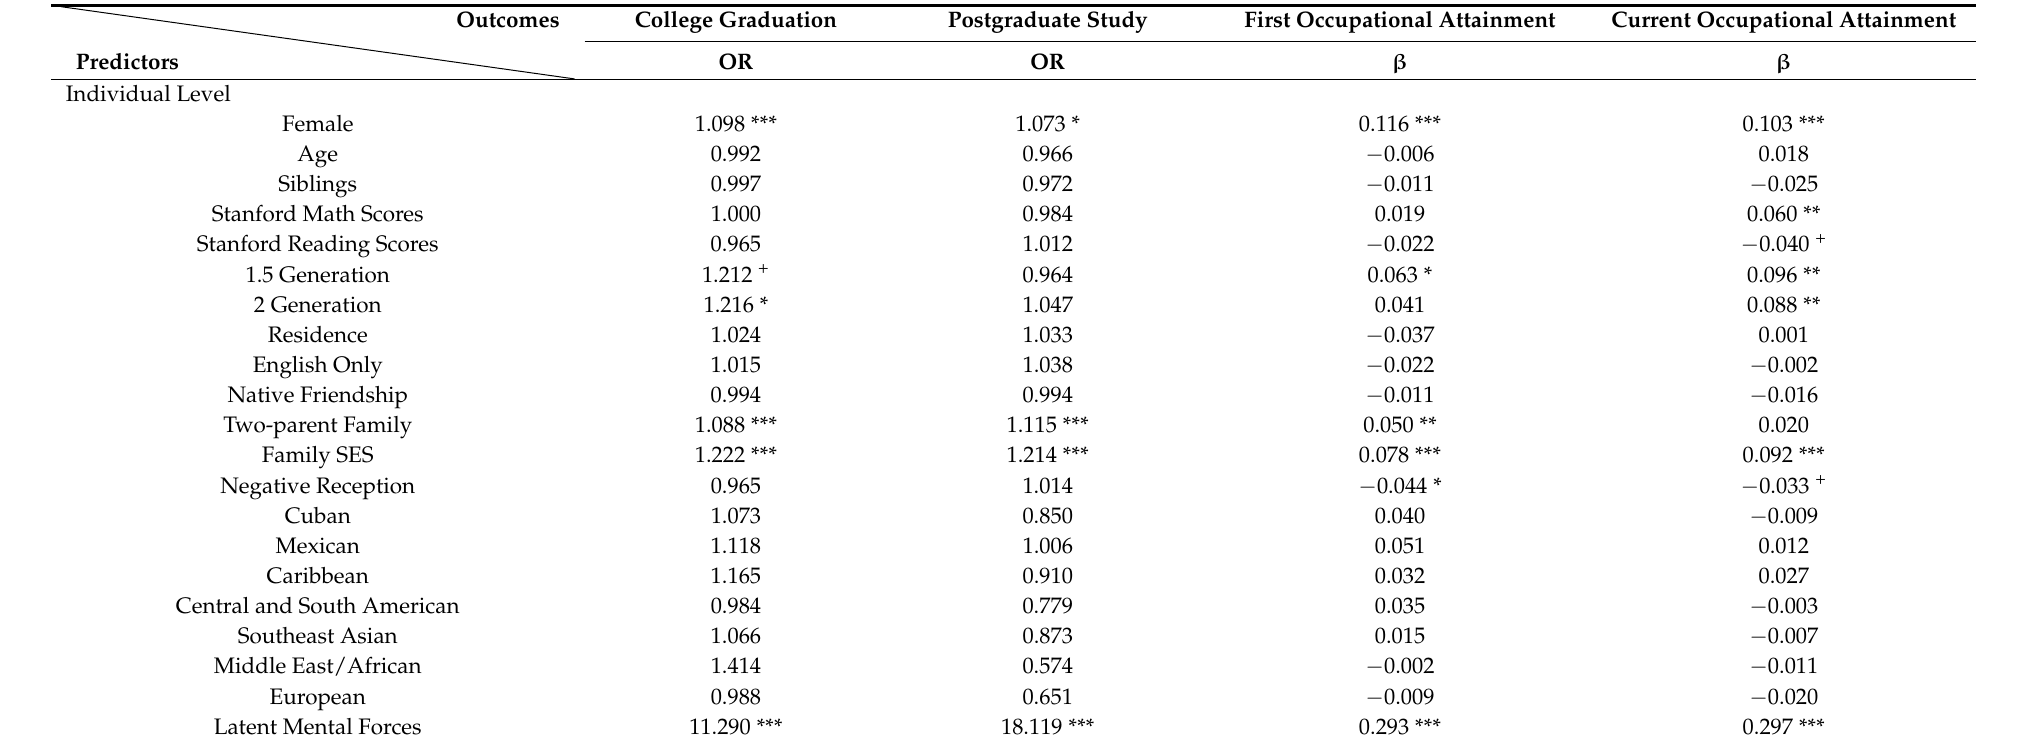
Table 6. Multilevel Modeling Effects of Social and Mental Forces on Adaptation Outcomes of Immigrant Children in Young